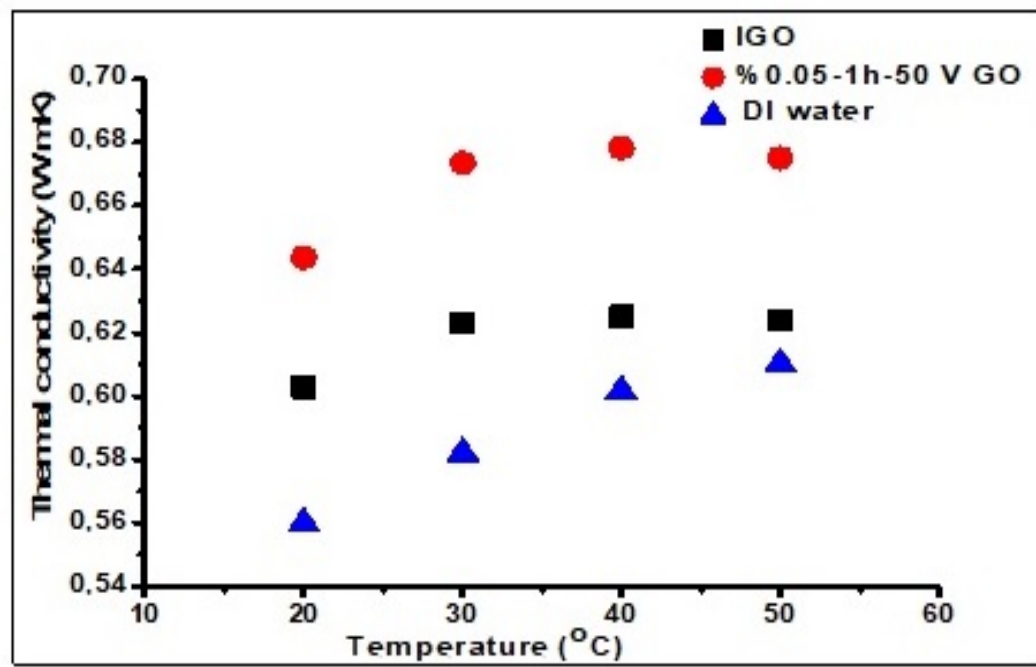
Figure 4: Thermal conductivity of 0.05%-1h-50 V GO and IGO